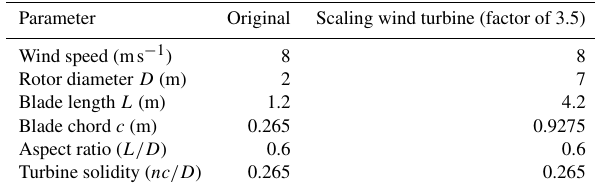
Table 1. Scaling-up of the VAWT.